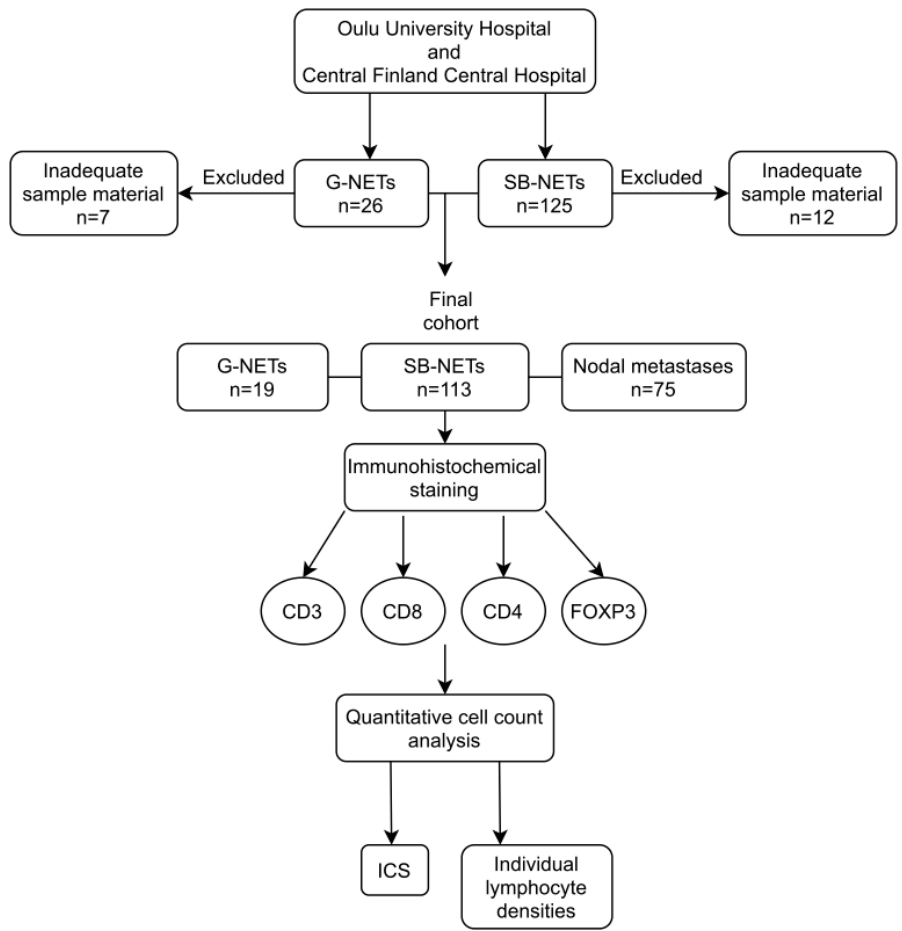
Figure 1. A flowchart summarizing the study cohort and the used methods. CD3 + , CD8 + , CD4 + and FOXP3 + immunohistochemistry was analyzed by J.P.V. using a previously validated cell counting method and QuPath v. 0.1.2 software (created at the Centre for Cancer Research & Cell Biology, Queen’s University Belfast, developed at the University of Edinburgh, Edinburgh, UK) [17,18]. Immune cell densities were measured at the tumor center and at the invasive margin. The invasive margin was defined as a region extending 0.5 mm from both sides of the tumor border (Figure